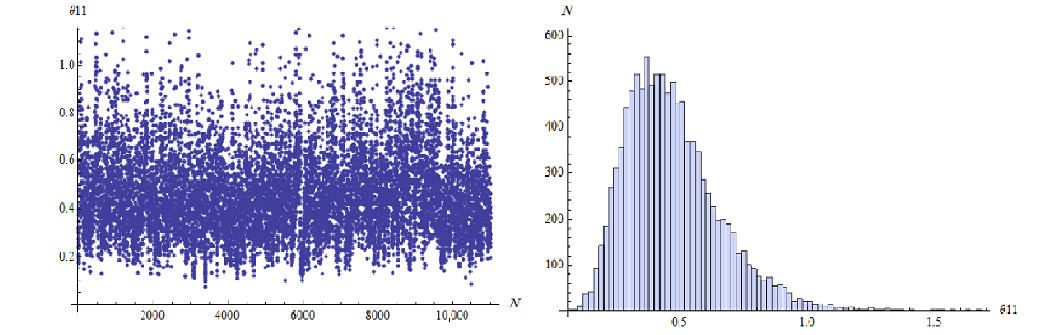
Figure 2. Trace ( Left ) and histogram ( Right ) plots of the parameter θ 11 .